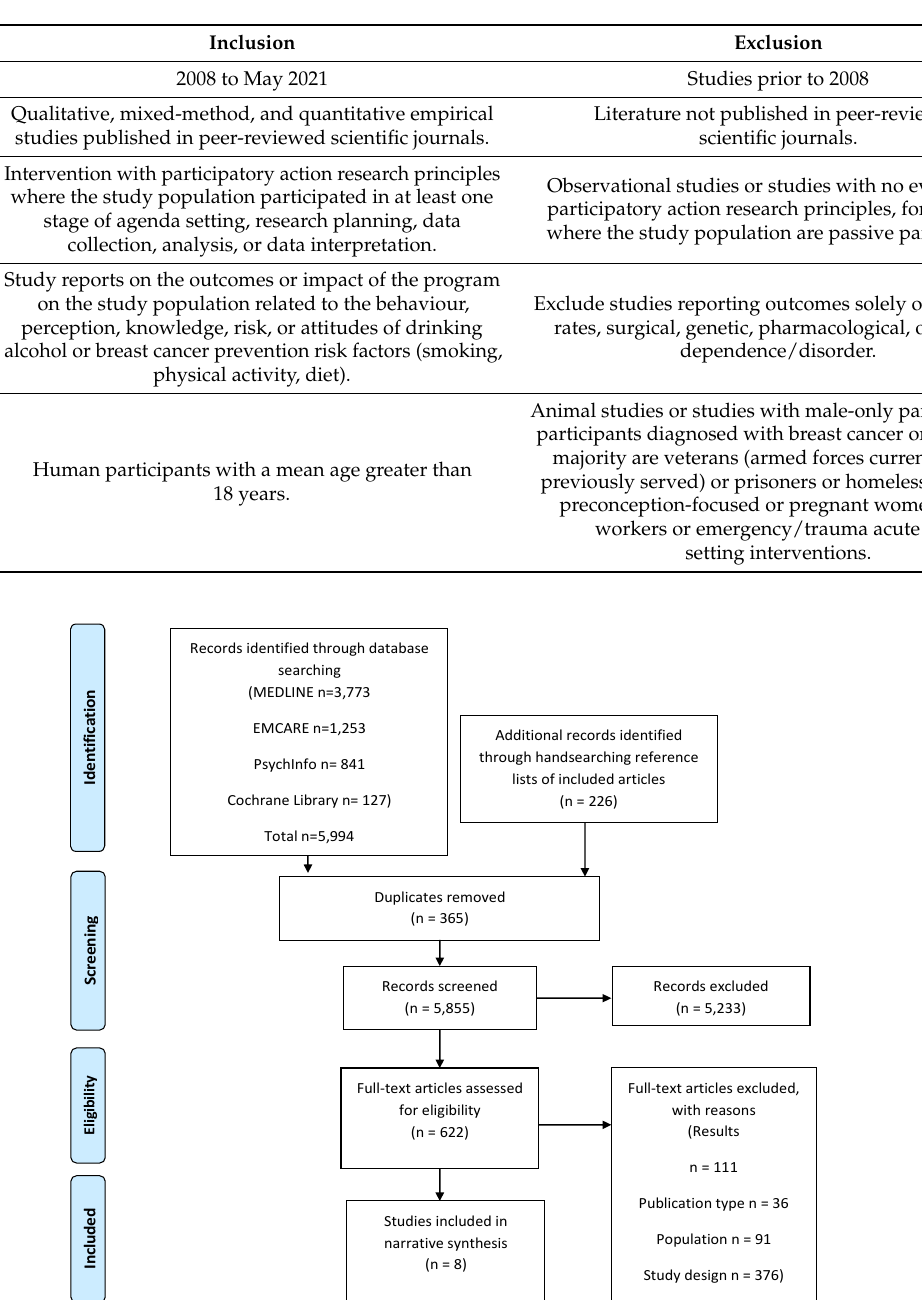
Table 1. Inclusion and exclusion criteria.